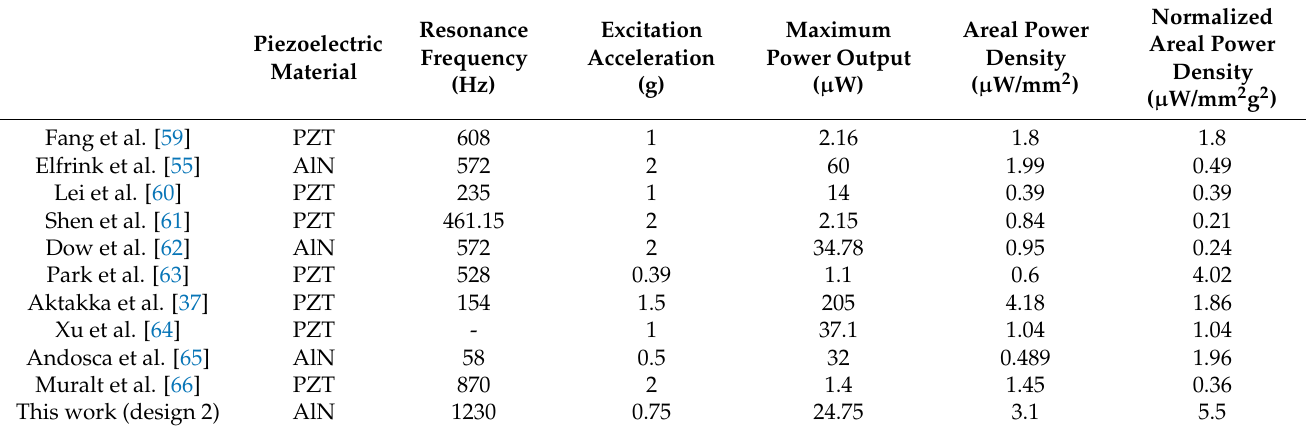
Table 5. Comparison of power output and power densities for mechanically excited energy